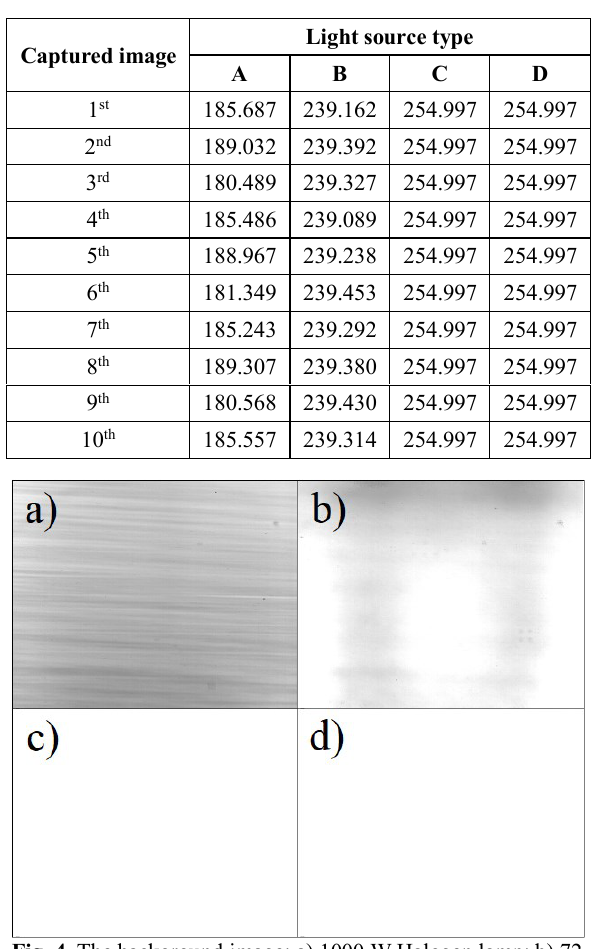
Table 2. Mean pixels value of taken images in installing 5th